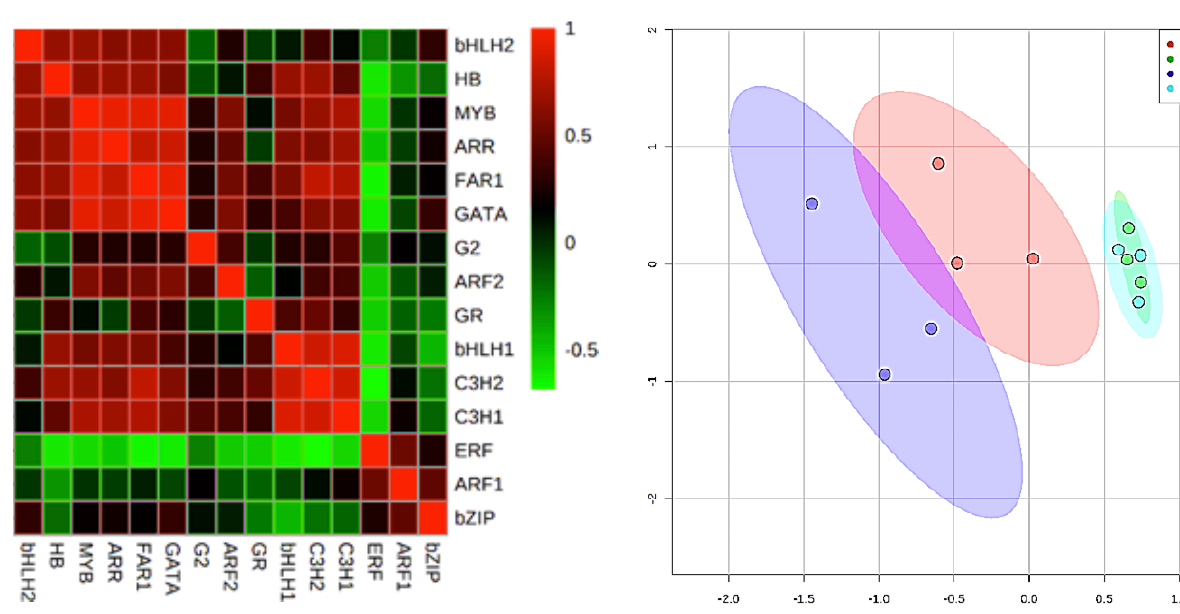
Figure 6. Heat map of the correlations among the top 15 genes.